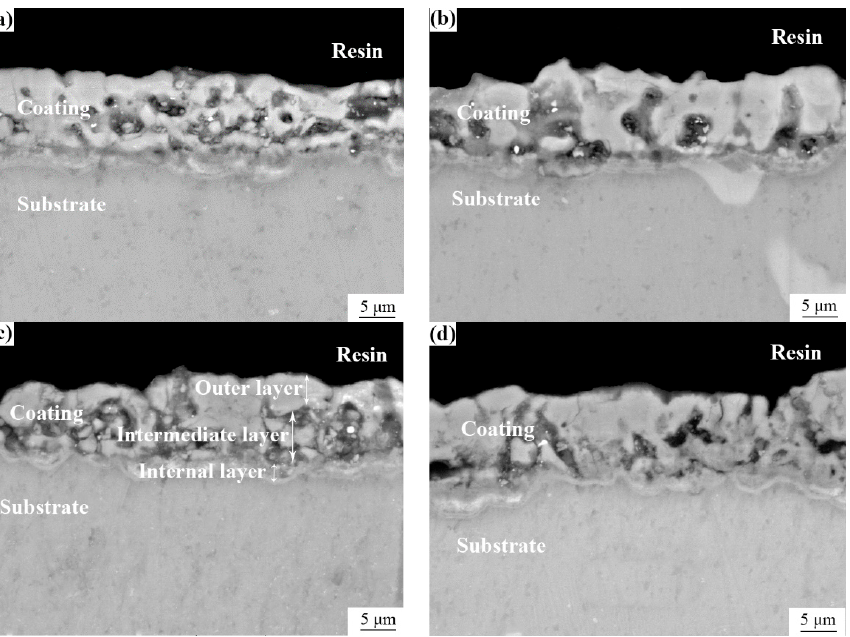
Figure 4. Cross-sectional morphologies of MAO coatings: ( a ) 5 min; ( b ) 10 min; ( c ) 15 min; ( d ) 20 min.